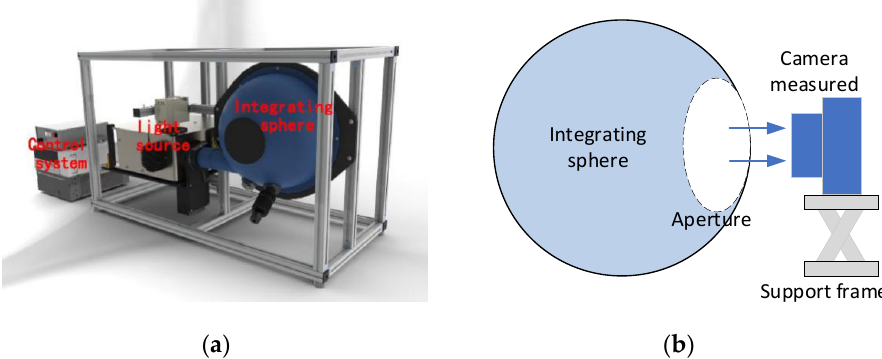
Figure 2. Integrating sphere system: ( a ) structure of integrating sphere system; ( b ) observation scheme of calibration.